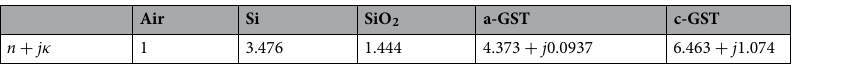
Table 1. Refractive index of the materials at 1550 nm. a-GST (c-GST) stands for GST in the amorphous (crystalline)